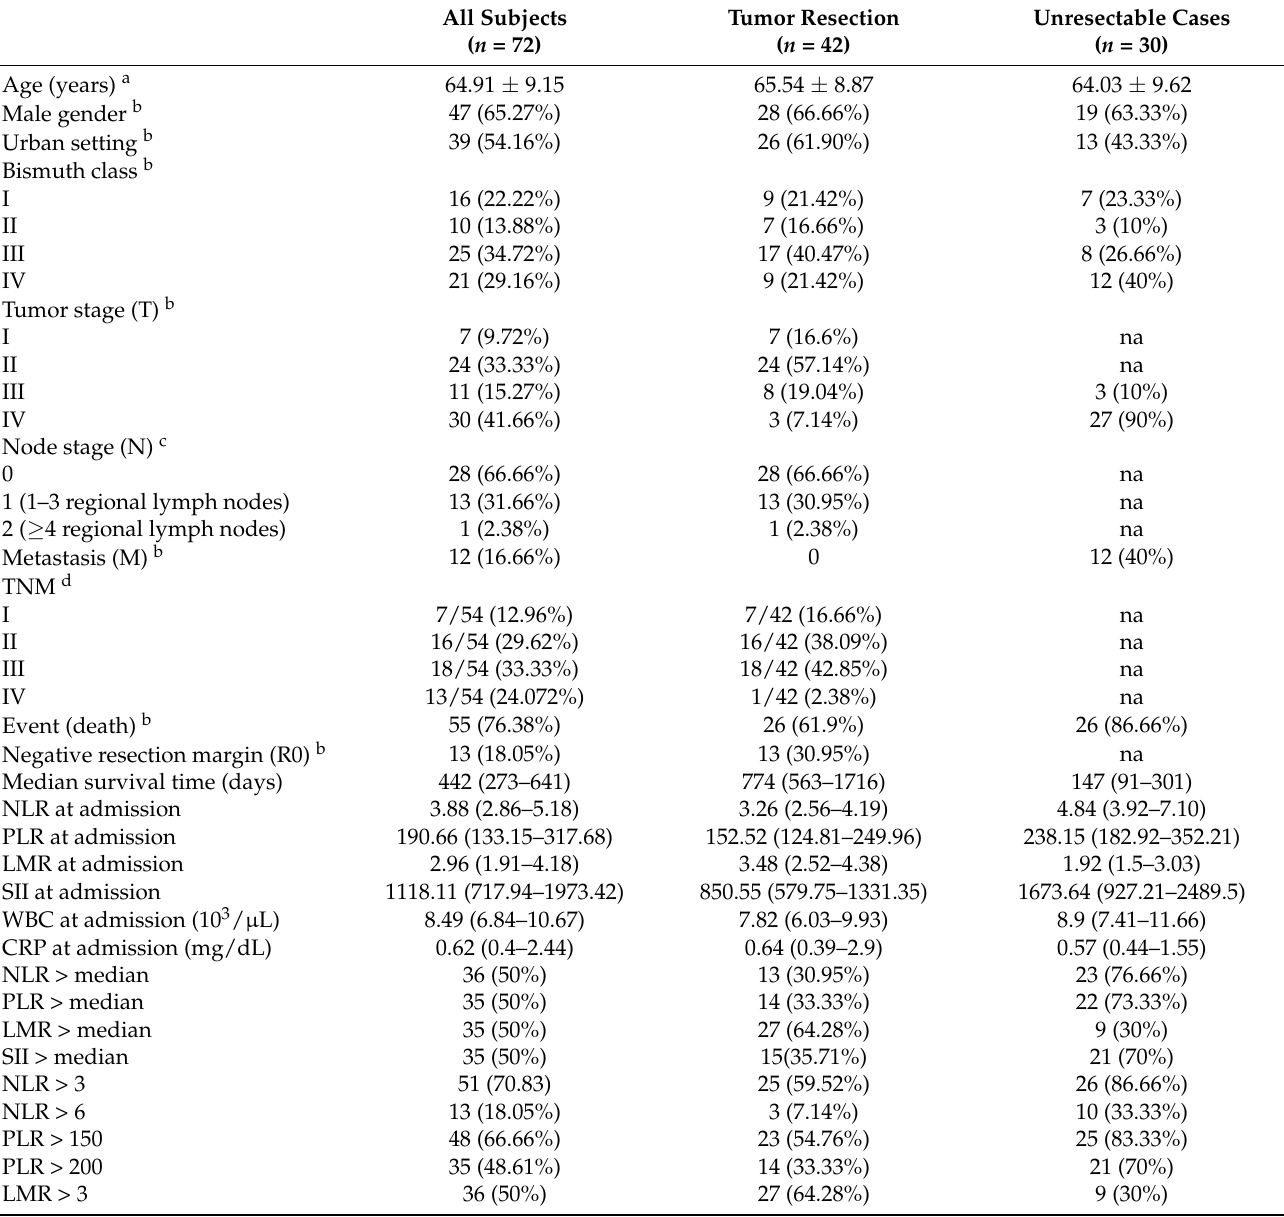
Table 1. Main characteristics of the subjects and inflammatory ratios regarding the